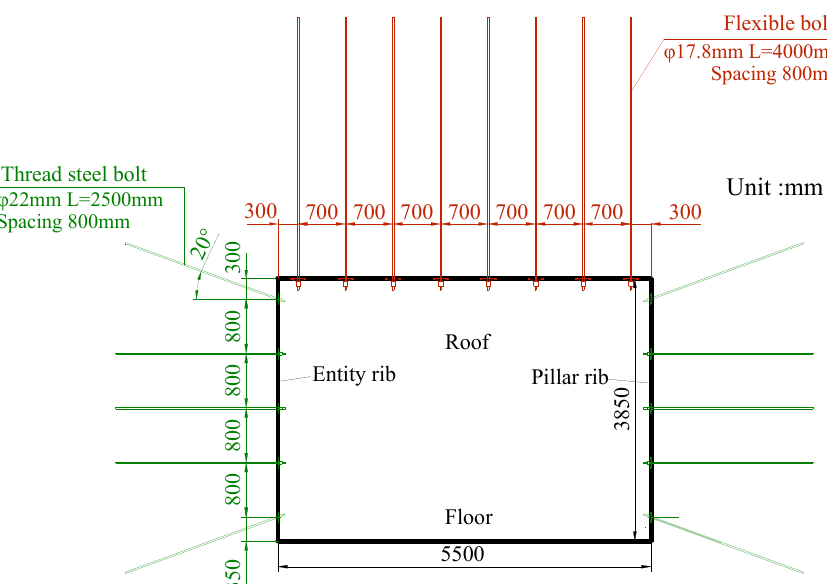
Figure 7. Main support section of flexible bolt.